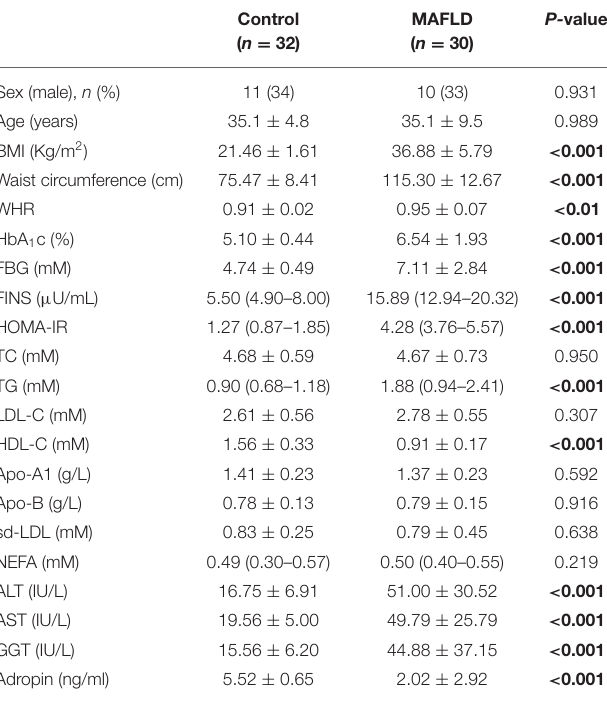
TABLE 1 | Anthropometric parameters and biochemical indexes in healthy controls and MAFLD patients.